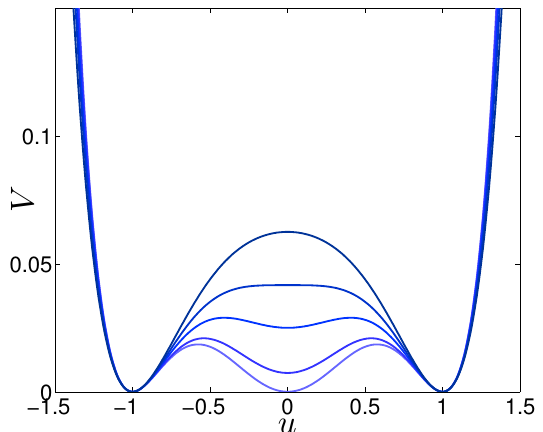
Figure 1 . The parametric φ 6 potential given in eq. (2.2) as ǫ is varied from 0 . 01 to 0 . 25 to 0 . 5 to 1 / √ 2 and to 1 (lighter color curves to darker color curves, respectively), showing the transition from a triple well to a double well. The local minimum at u = 0 disappears at ǫ = 1 / √ 2.